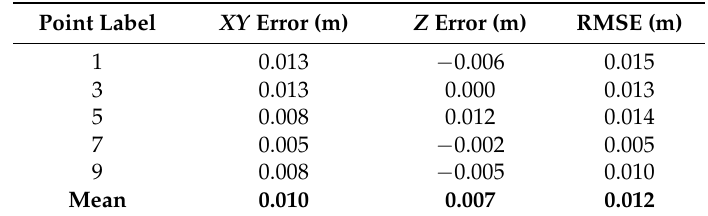
Table 2. Ground Control points. “ XY error” is the root mean square error for X and Y coordinates for a GCP location, “ Z error” is the error for Z coordinate for a GCP location, “RMSE” is the Root Mean Square Error for X , Y , Z coordinates for a GCP location and “Mean” implies averaging over all the GCP locations.